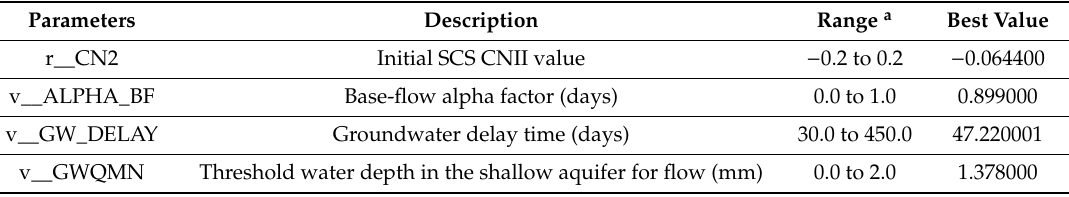
Table 2. Initial values for the adjusted parameters and best fitted values after calibration with SUFI-2.